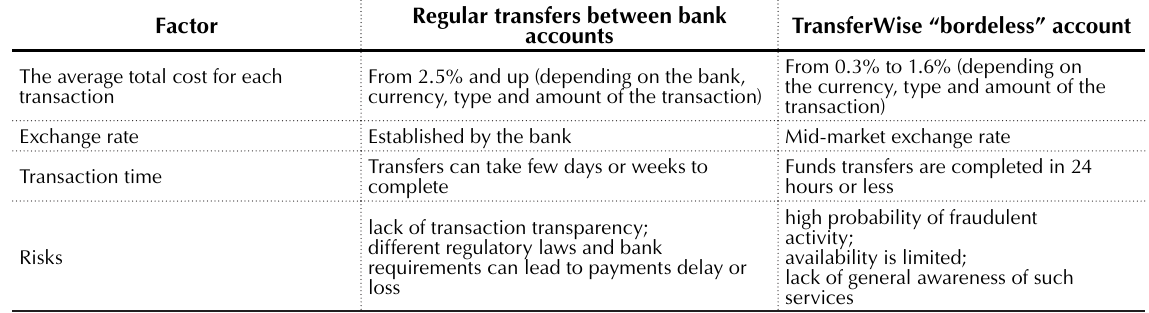
Source: Created by the authors.